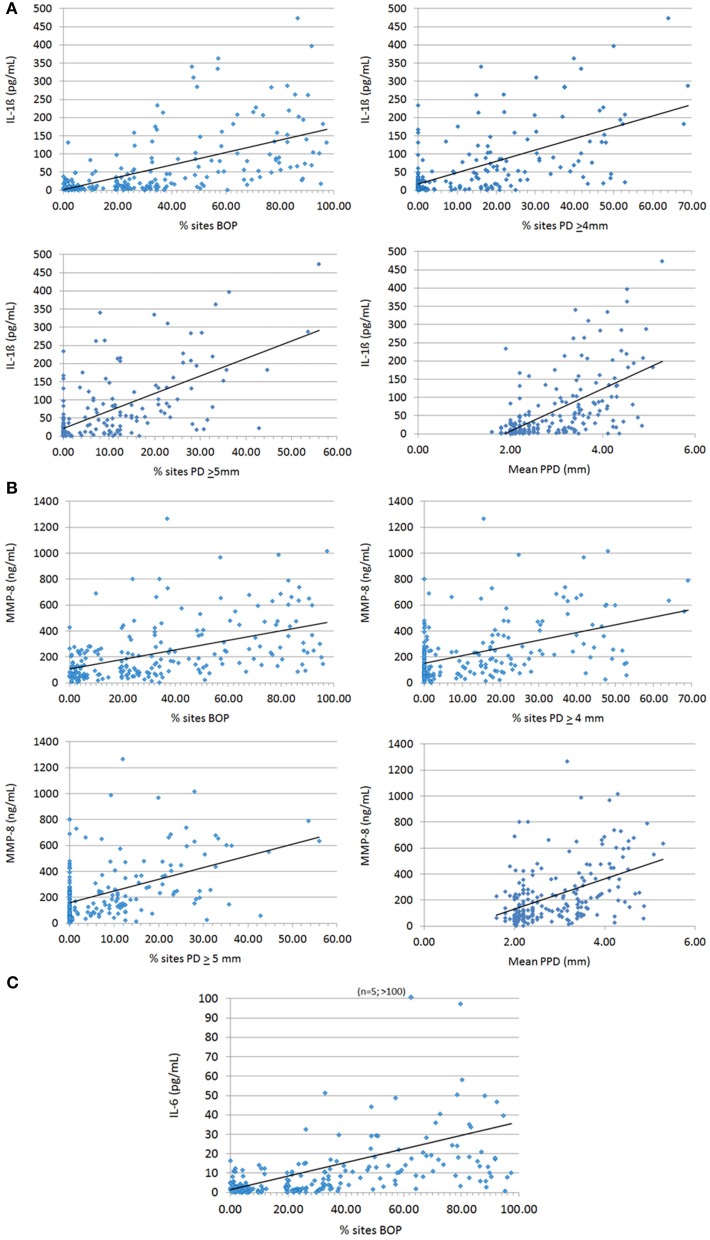
Correlation analyses of biomarkers IL-1ß (A), MMP-8 (B), and IL-6 (C) significantly related to clinical indices of periodontitis. Each point denotes a patient in the population (n = 209) and the line denotes the correlation trendline.